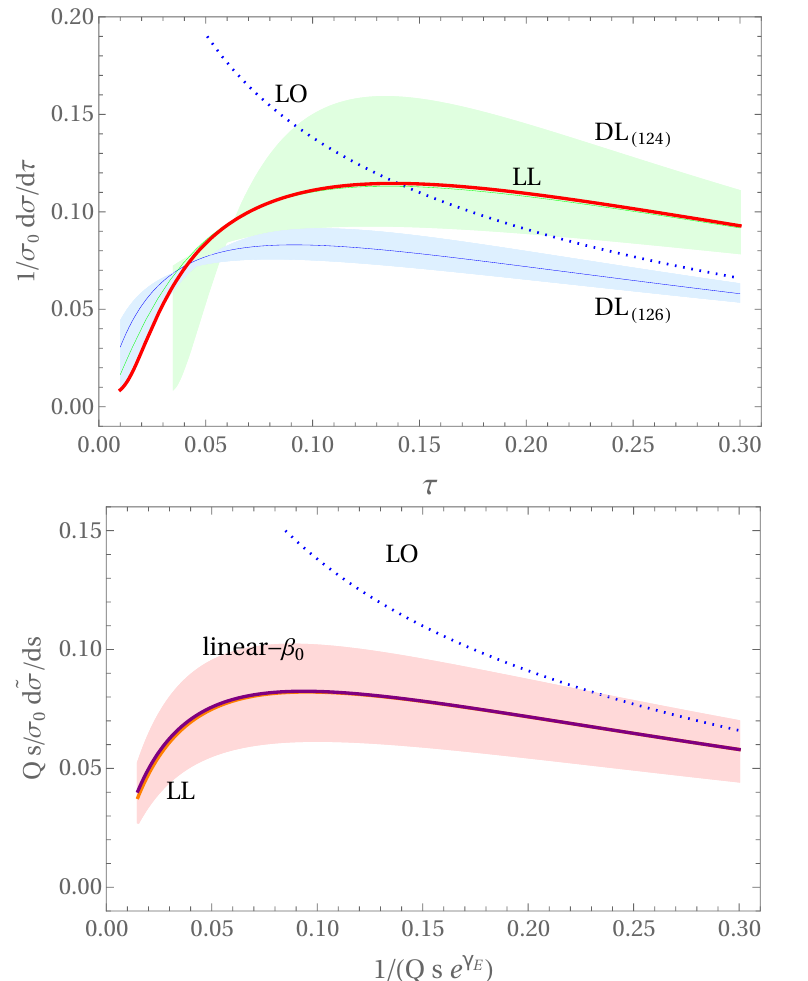
dσ in the double-logarithmic approximation σ 0 dτ e dσ , in σ 0 ds